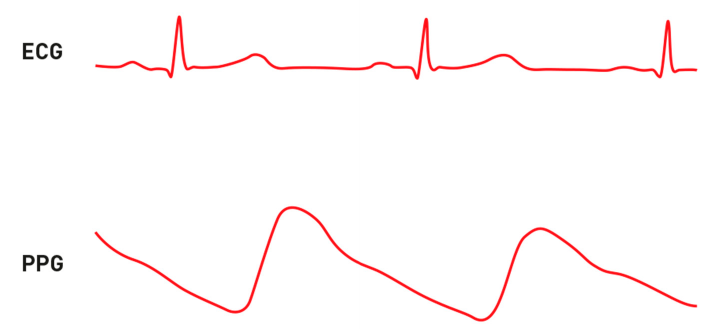
Figure 6. 1-lead ECG and photoplethysmography (PPG) example traces.